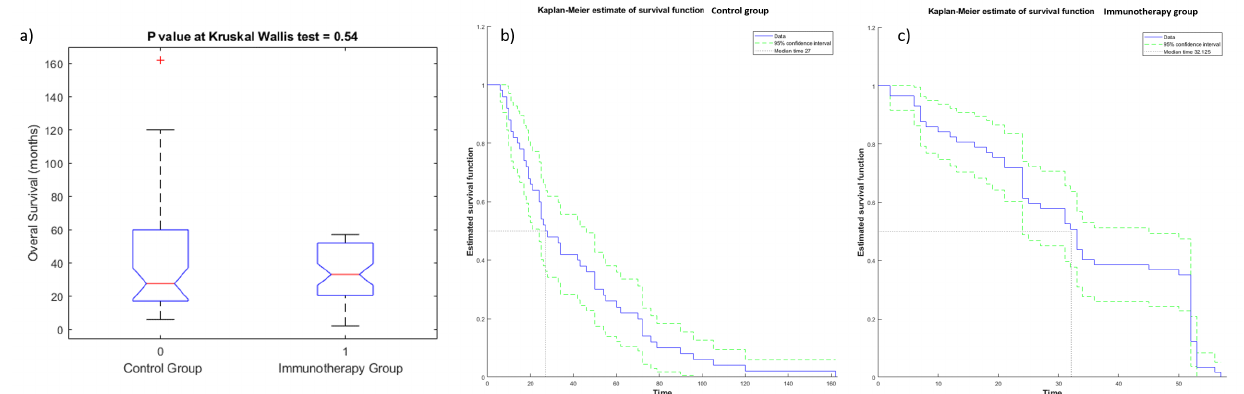
Figure 3. Boxplot ( a ) and Kaplan—Meier curve of OS for patients of control group ( b ) and of immunotherapy group ( c ).